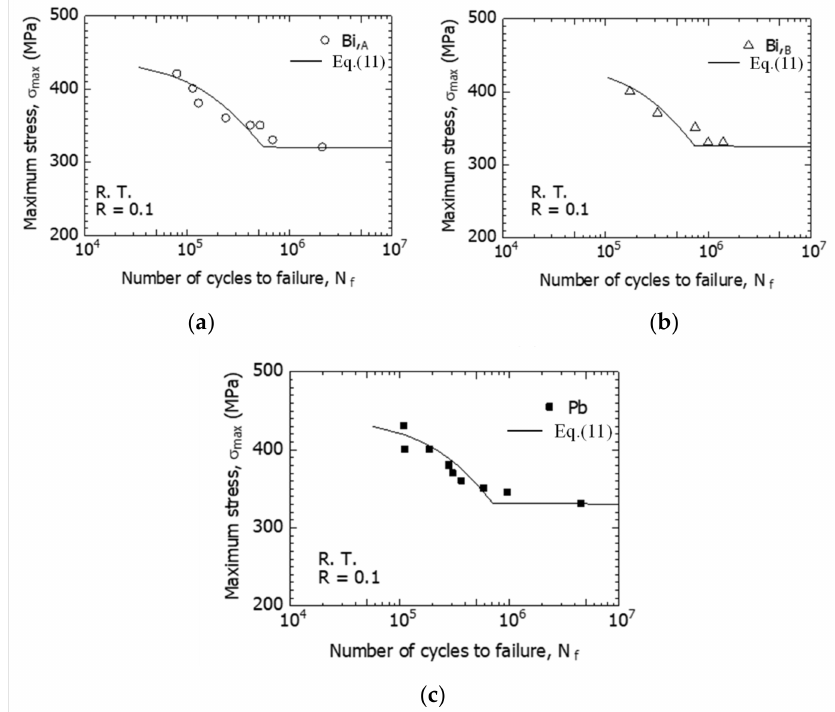
Figure 13. Calculation from d a /d N ( S − N curves): ( a ) Bi, A ; ( b ) Bi, B ; and ( c )